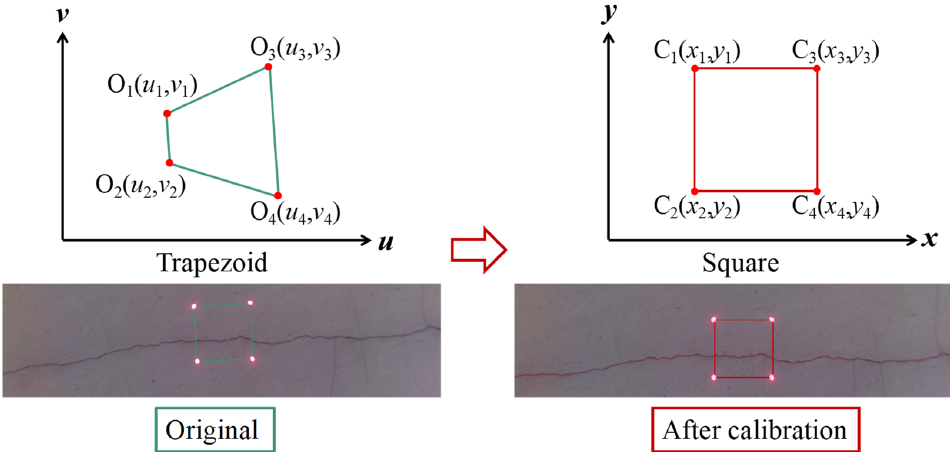
Figure 6. Schematic showing the image geometric correction algorithm.